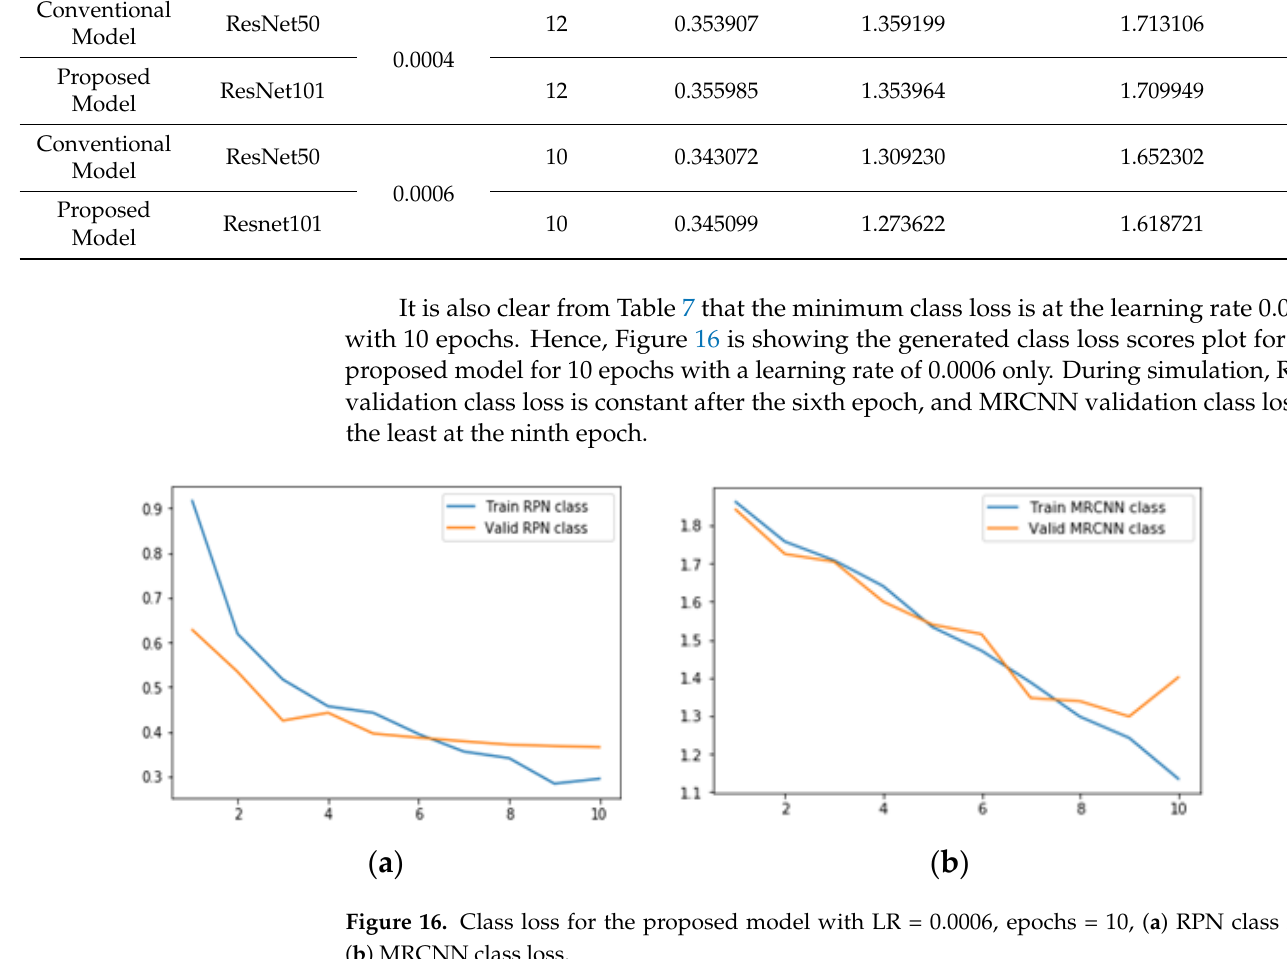
Table 7. Class loss values for validation data with different learning rates and epochs.